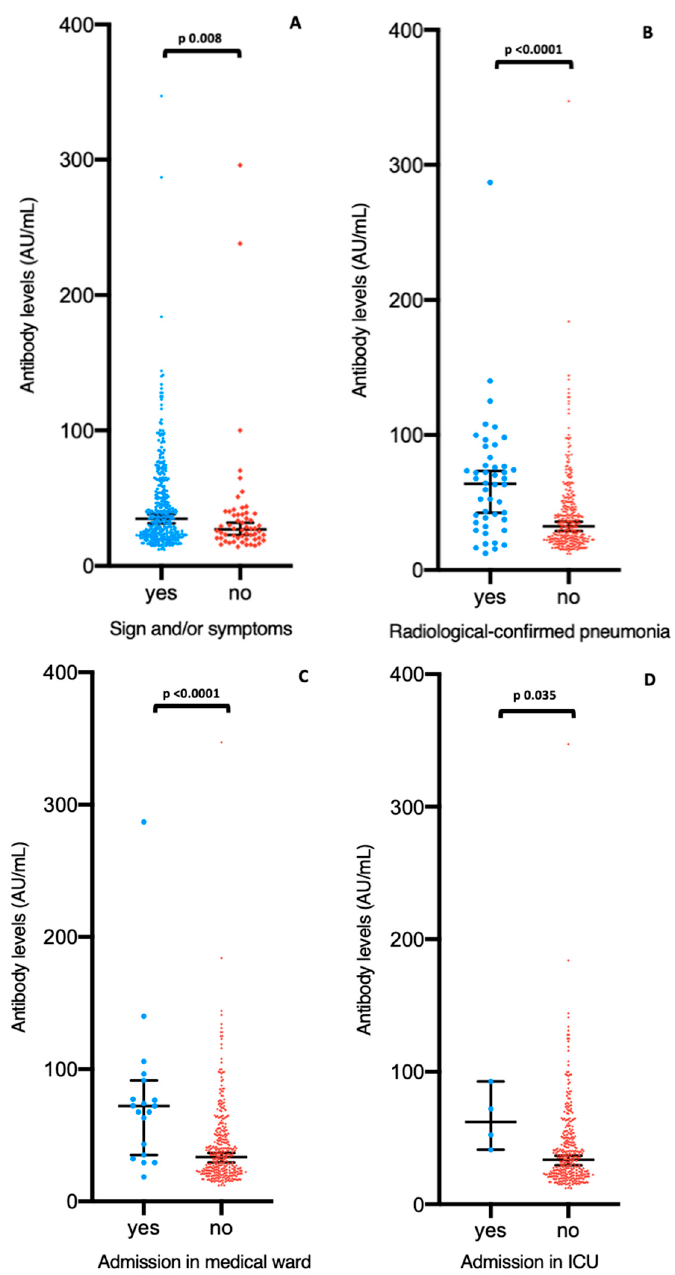
Figure 3. Levels (AU/mL) of IgG by symptoms ( A ), radiologic confirmed pneumonia ( B ), admission at non intensive medical ward ( C ), and admission in ICU ( D ). For ( A ), data are shown only for seropositive subjects for IgG ( n = 433). For ( B – D ), data are shown only for seropositive and symptomatic subjects for IgG ( n = 377). The center line of boxes depicts the median of IgG concentration; the lower and upper hinges correspond to 95%CI. Wilcoxon rank test was used to assess statistically significant differences in antibody levels between groups in ( A – D ).